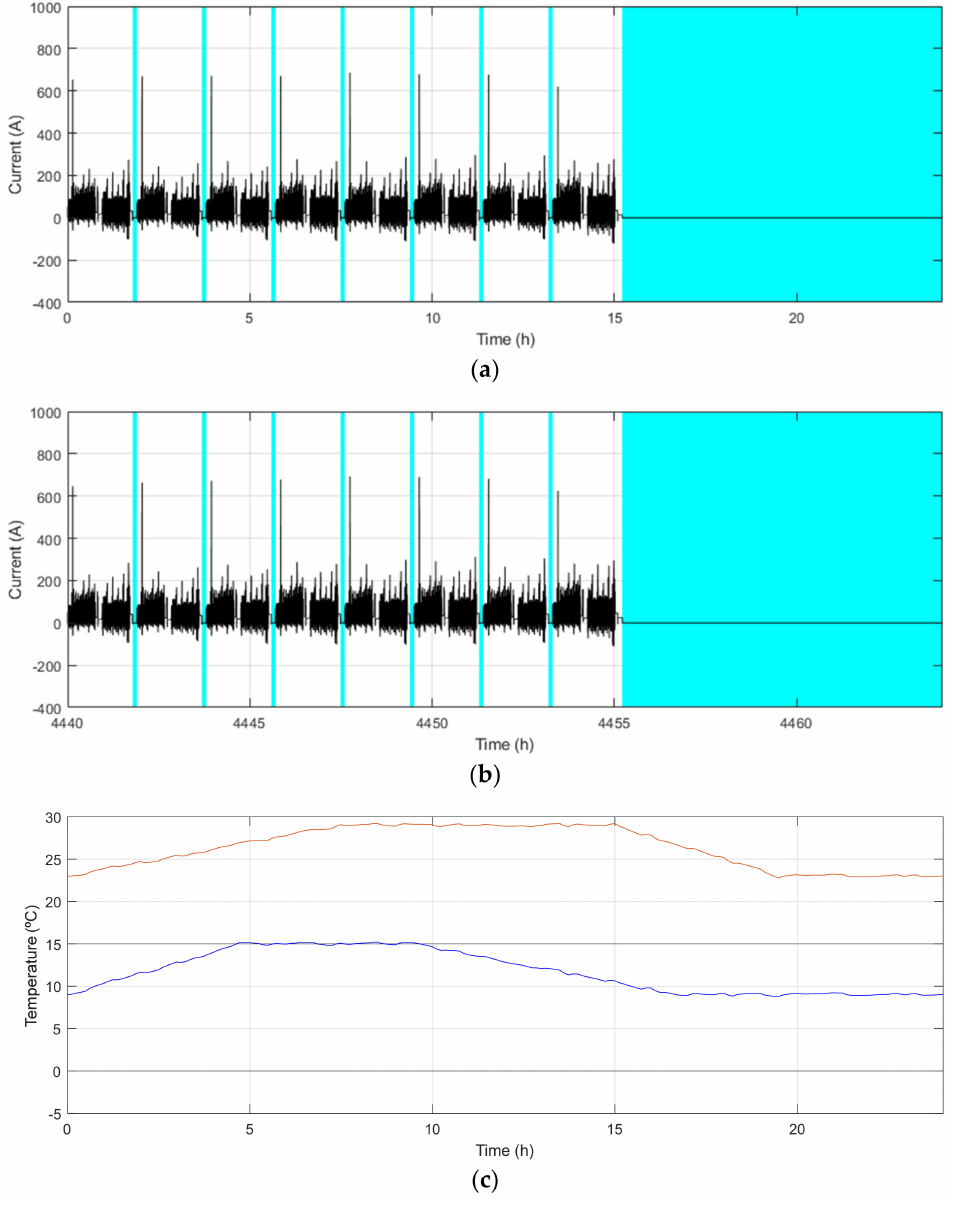
Figure 5. Current and temperature profiles in BCN scenario. ( a ) Current profile, 1 January. Cyan: Charging Points. ( b ) Current profile, 1 July. Cyan: Charging points. ( c ) Temperature Profile. Blue: January; Red: